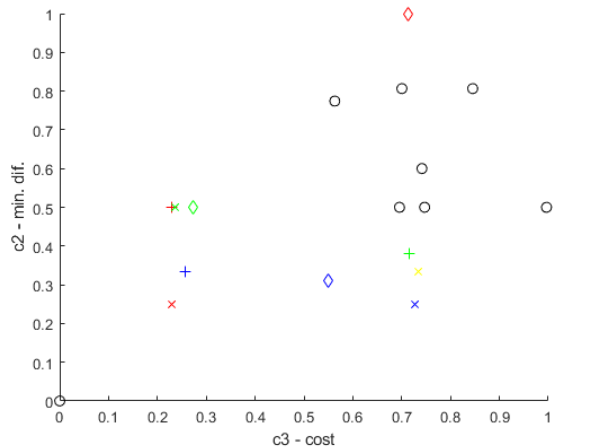
Figure 17. Particle Swarm Optimization. Swarm size: 200. Black ball—LHS. Others, see Table